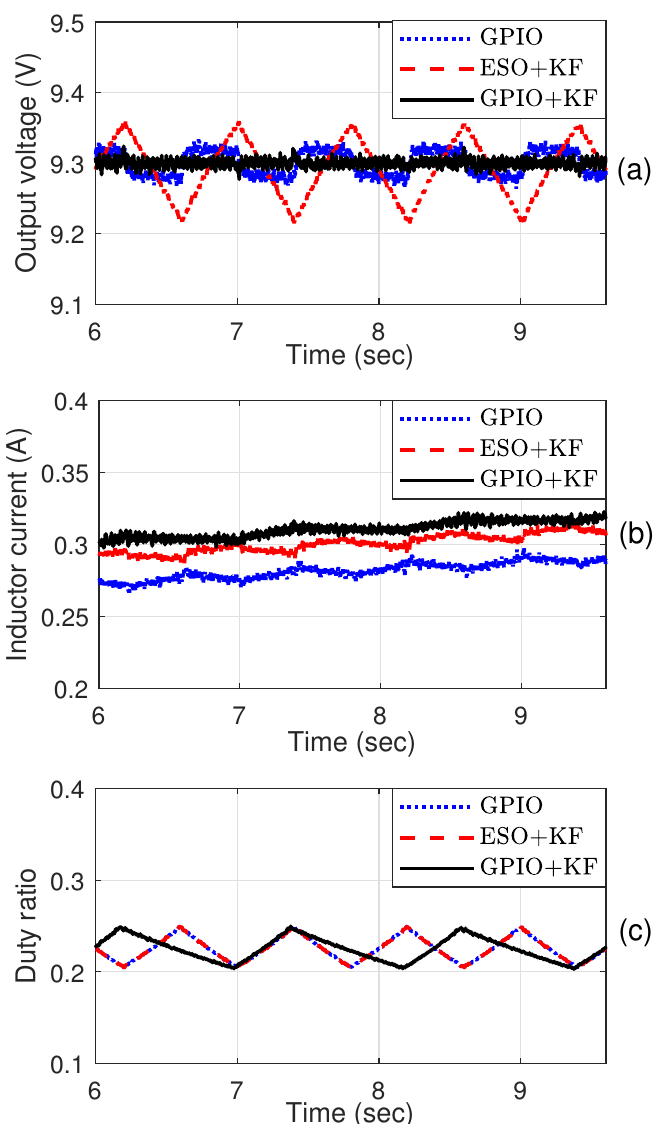
Figure 5. Waveform curves when disturbance is polynomial form of time series. ( a ) Output voltage. ( b ) Inductor current. ( c ) Duty